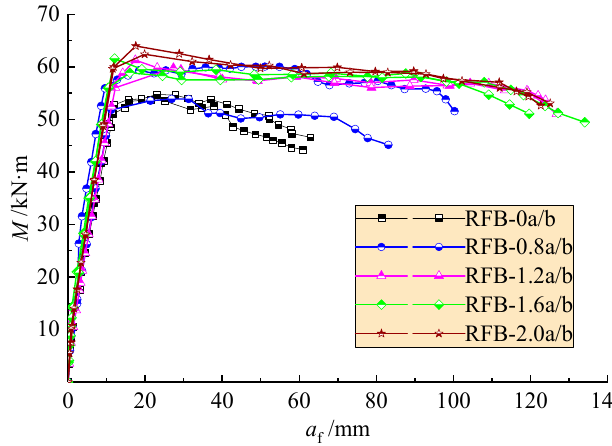
Figure 9. Mid-span deflection changed with moment of the test beams.